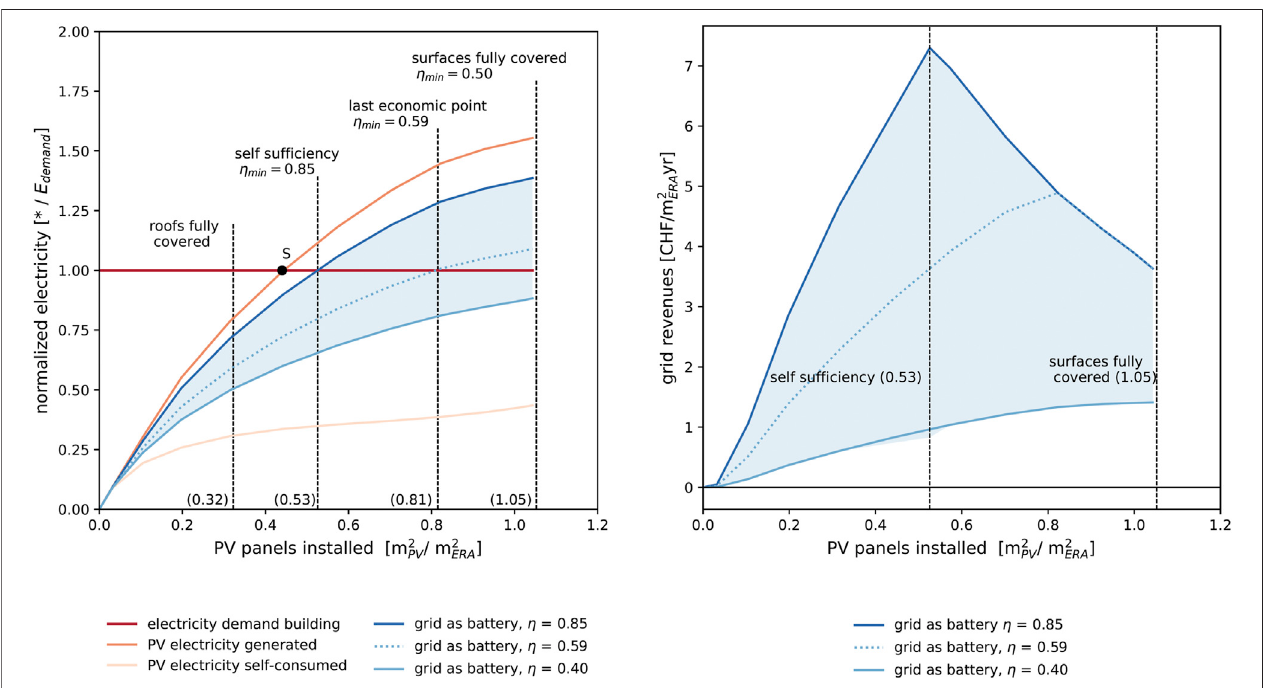
FIGURE 9 | (A) The need for PV panels of 31 buildings balanced at the transformer to reach self-suf fi ciency (SS) with reimport for different round-trip ef fi ciencies η . Point S: full SS with ideal storage ( η (cid:1) 100%) in place. (B) Revenues as a function of installed PV capacity and grid ef fi ciency from the perspective of the grid. The grid operator buys electricity at a feed-in tariff of 0.08 CHF/kWh and resells for electricity price 0.20